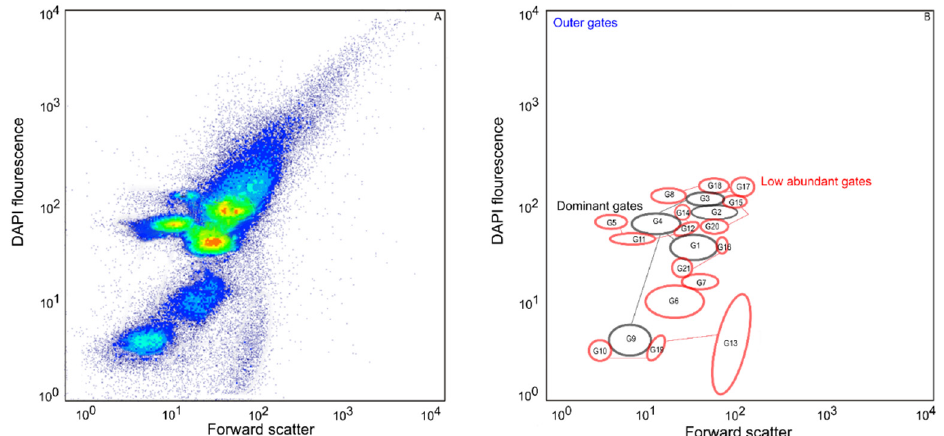
Figure 1. Visualization of microbial community dynamics. ( A ) Microbial community analysis based on fluorescence signals of cells. ( B ) Representation of gates for separated sub-communities. Dominant gates are delimited with black color (116,796 cells), low abundant gates are delimited with red color (56,776 cells) and outer cells are not in the delimited gate.